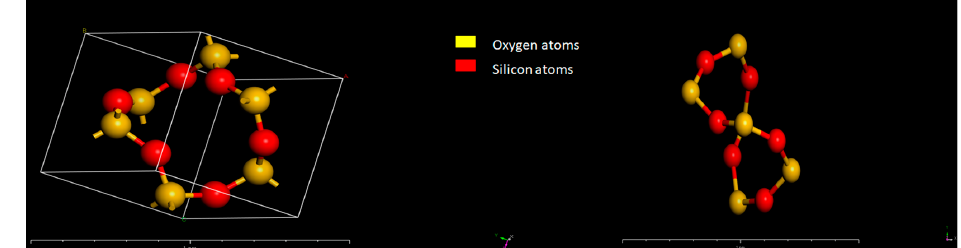
Figure 2. Quartz structural unit, linked in continuous silicon-oxygen